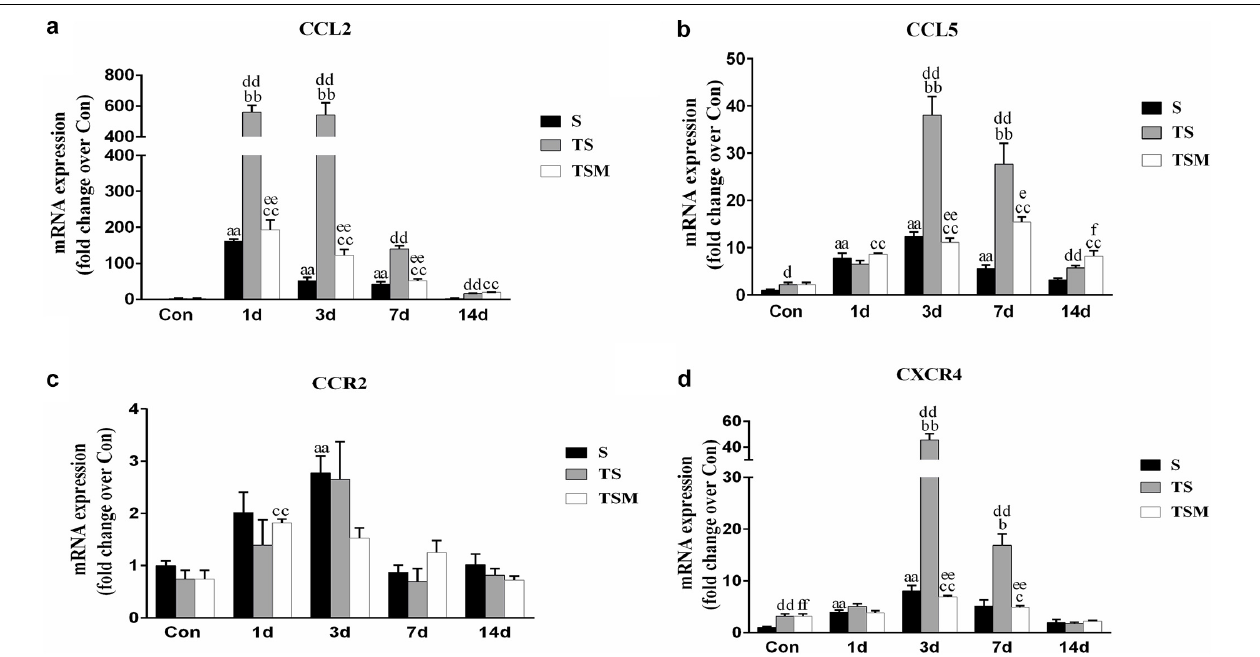
FIGURE 8 | Effects of MGF injection on the expression of chemokines in injured skeletal muscle after macrophage depletion. (a) The expression of CCL2; (b) The expression of CCL5; (c) The expression of CCR2; (d) The expression of CXCR4. S, muscle contusion group; TS, muscle contusion and macrophage depleted group; TSM, muscle contusion, macrophage depletion and MGF treated group. Data are means ± SEM, n = 8; a Significant difference from Scon, p < 0.05; aa p < 0.01. b Significant difference from TScon, p < 0.05; bb p < 0.01. c Significant difference from TSMcon, p < 0.05; cc p < 0.01; d Significant difference between group TS and group S, p < 0.05; dd p < 0.01; e Significant difference between group TS and group TSM, p < 0.05; ee p < 0.01; f Significant difference between group TSM and group S, p < 0.05; ff p < 0.01.